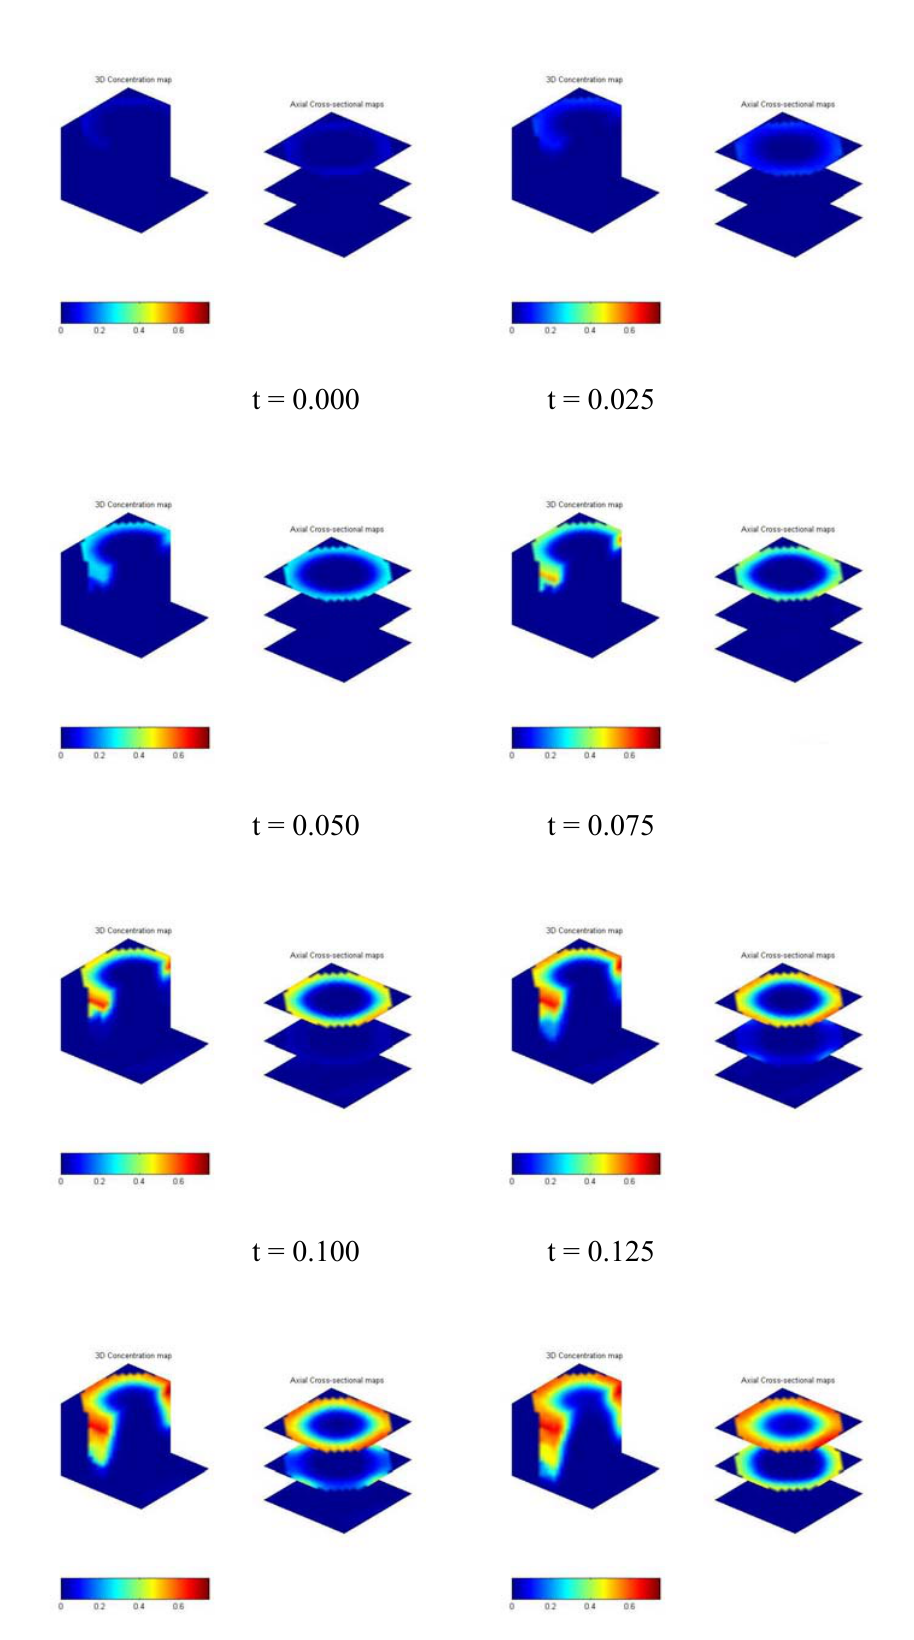
Figure 13. Three-dimensional dynamic view of the cylindrical object moving in the vessel from